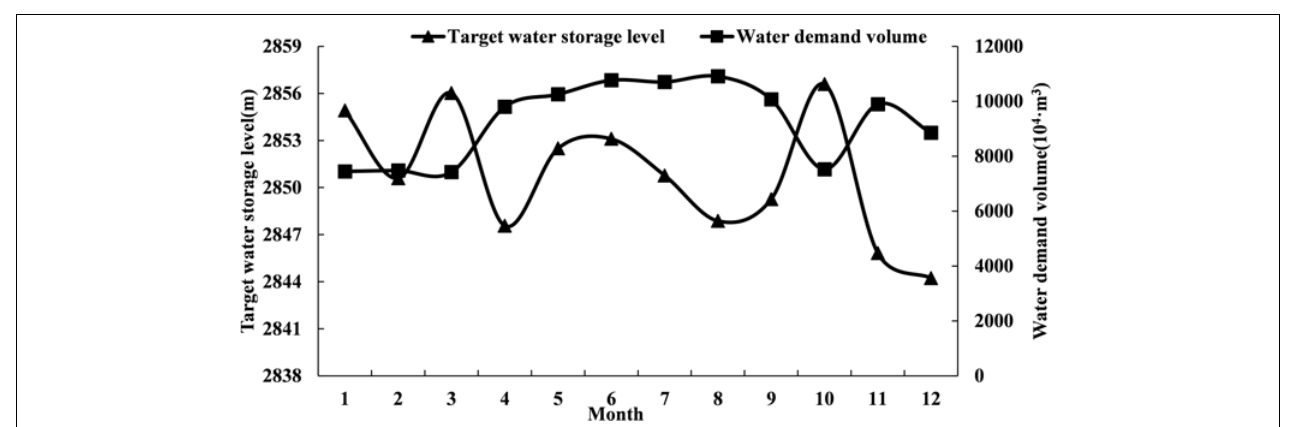
FIGURE 14 | The target storage level and water demand of HQ